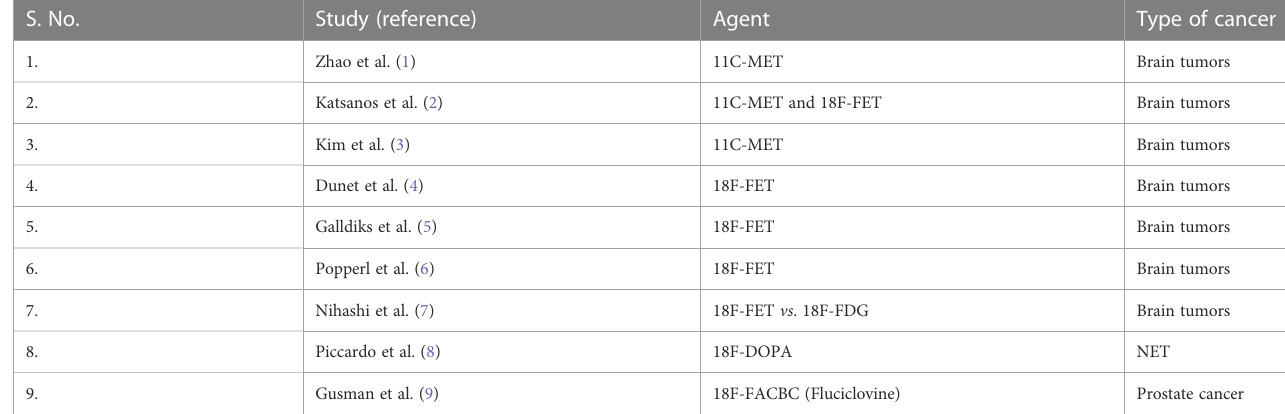
TABLE 1 Important amino acid